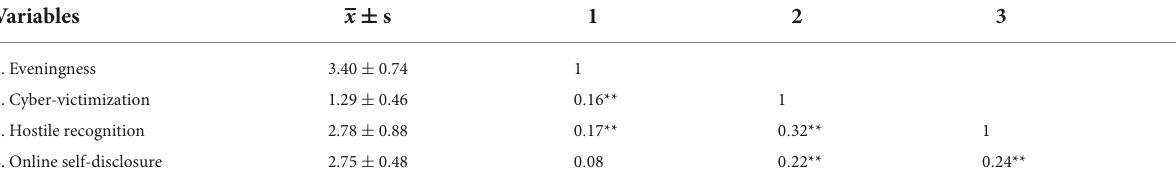
TABLE 1 Descriptive statistics and correlation matrix among principal variables ( n = 583).